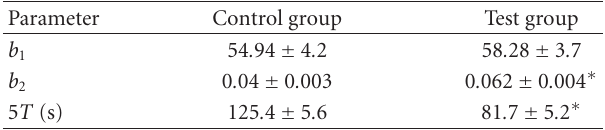
TBARS concentration 19 . 64 ± 3 . 17 · 10 − 6 18 . 33 ± 2 . 15 · 10 − 6 period (mM) Values are represented as mean ± S.E.M ( n = 10). Table 3: Calculated mathematical parameters ( b 1 and b 2 ) in the control and test groups, and time within which the maximal pressure is developed (taken as 5 T ). Parameter Control group Test group b 1 5 T (s) 125 . 4 ± 5 . 6 81 . 7 ± 5 . 2 ∗ Values are represented as mean ± S.E.M. ( ∗ ) represents significantly di ff erent values between control and test group, P < . 01; n =